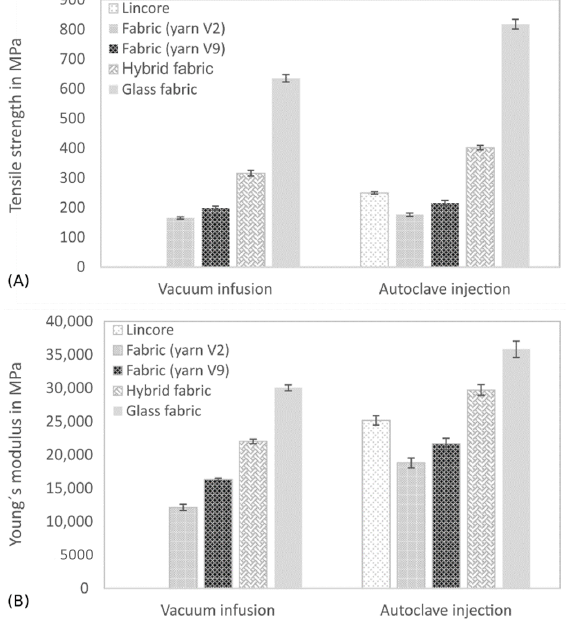
Figure 9. Tensile strength ( A ) and Young’s modulus ( B ) of composites produced by vacuum infusion and autoclave injection. The results are shown as mean values with the standard deviation as error bars.